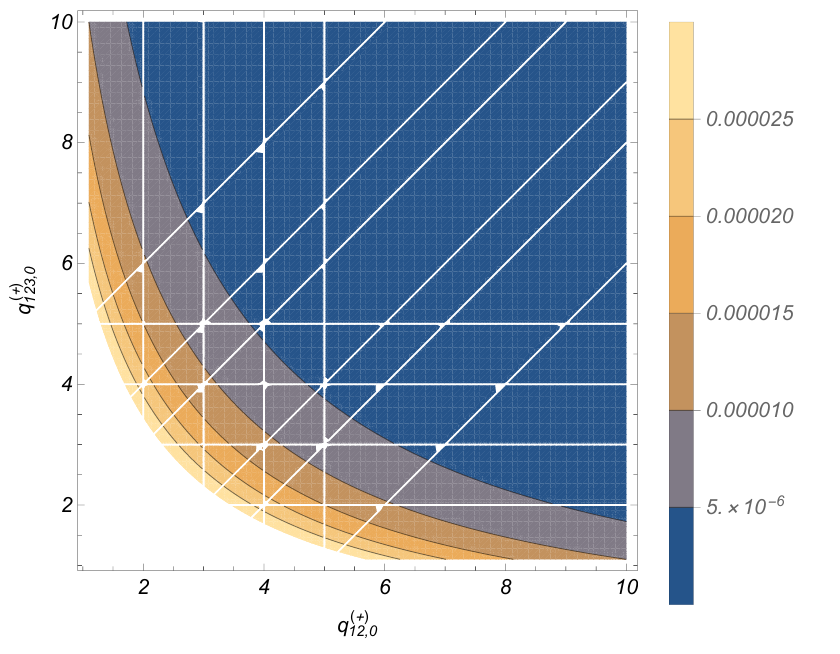
Figure 6 . Integrand-level behaviour of the noncausal LTD representation of a four-loop N 3 MLT diagram. White lines indicate the position of noncausal thresholds.